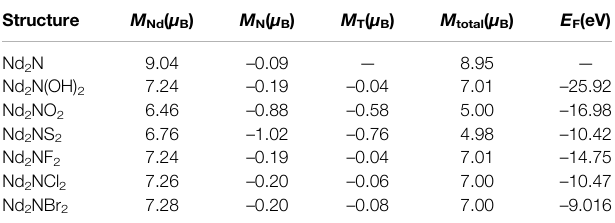
TABLE 2 | Total atomic magnetic moment ( M total ) and atomic resolution magnetic moment ( M ), and formation energy ( E F ) of the two-dimensional MXene materials Nd 2 N and Nd 2 NT 2 (T = OH, O, S, F, Cl, and Br).